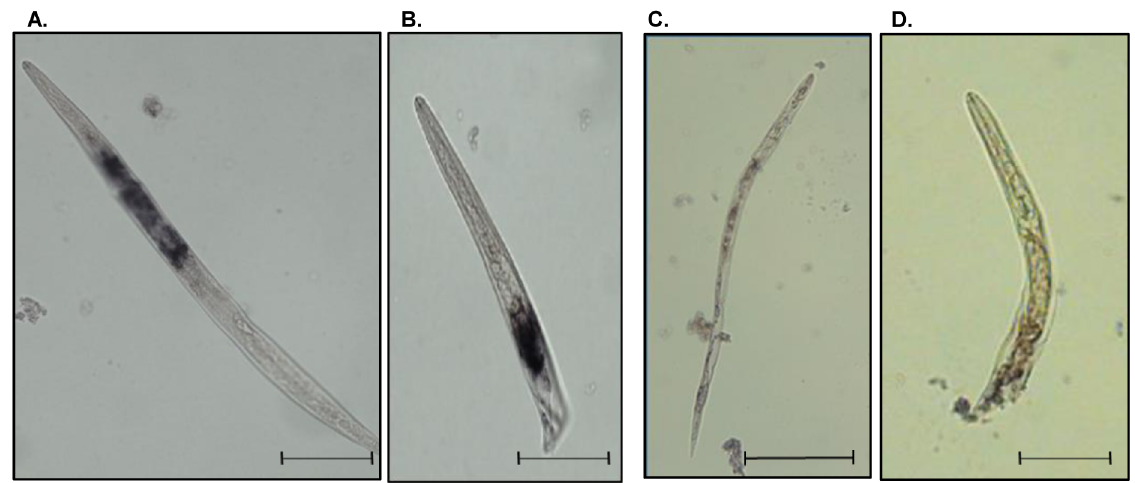
Fig 3. Subventral gland localization of MiPFN3 DIG-labeled cDNA probe in M . incognita J2. (A) and (B) representative photos of the MiPFN3 antisense probe binding to the subventral glands. Bar = 50 μ m. (C) and (D) Sense probe of MiPFN3 did not hybridize to the nematode. Bar = 100 μ